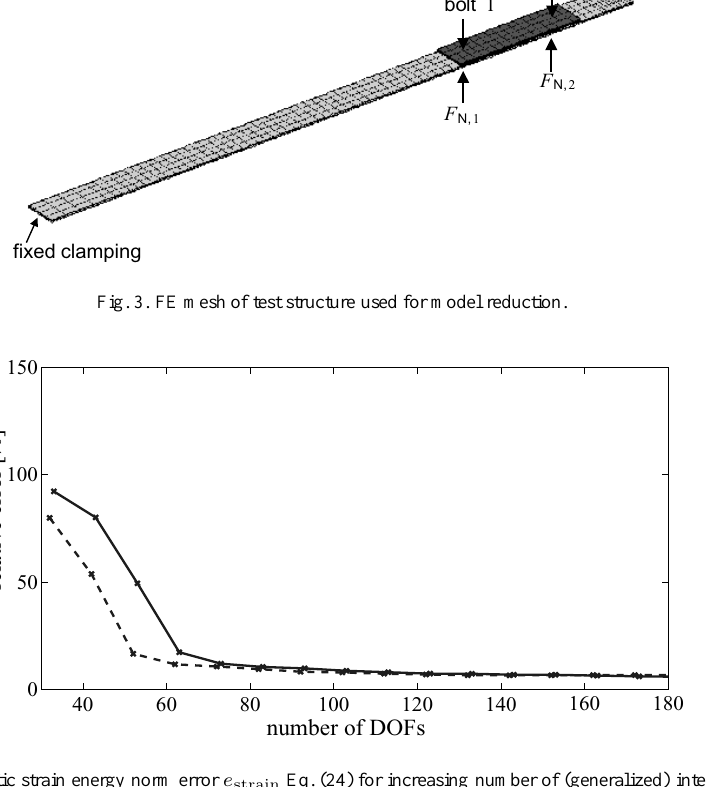
Fig. 4. Comparison of the static strain energy norm error e strai n Eq. (24) for increasing number of (generalized) interface DOFs for method A (–) and method B (- - -). increasing number of retained generalized interface DOFs is evaluated. For that, all static loads are applied, i.e. the bolt pretension is modeled by prescribed normal forces F N , 1 and F N , 2